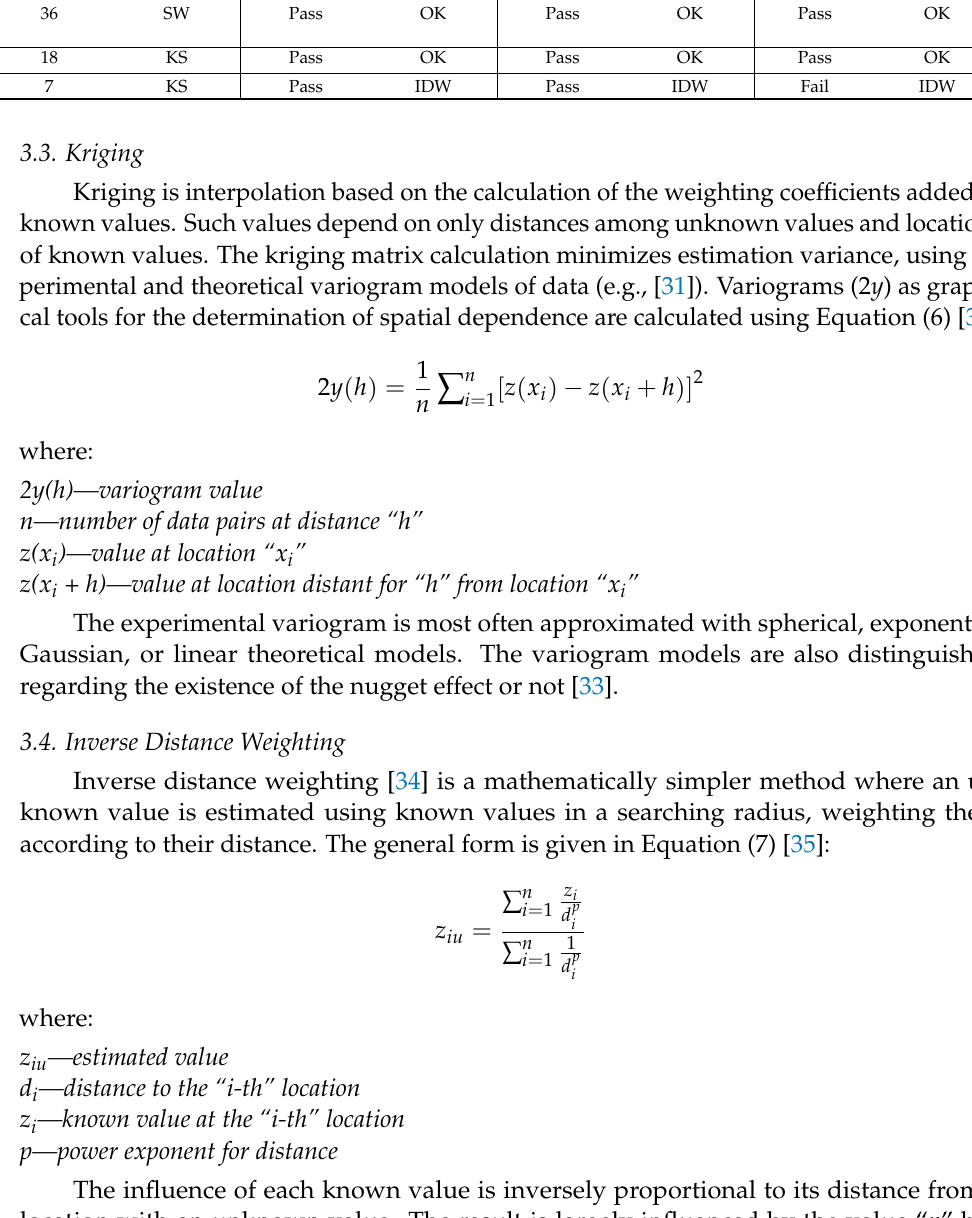
Lithological Unit